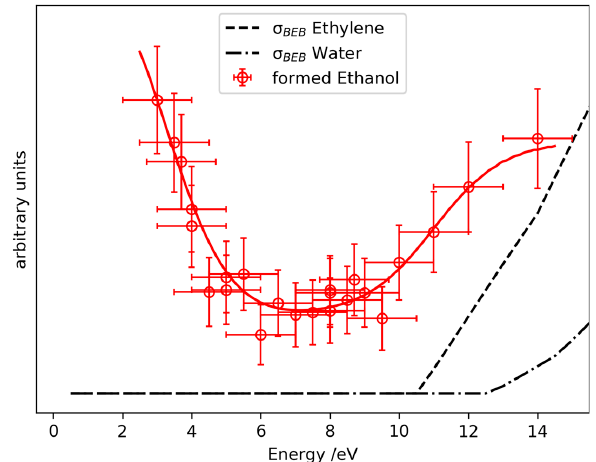
Figure 4. Predicted (black lines) electron impact cross-sections for ethylene and water. The amount of ethanol actually formed by electron irradiation of a 1:1 mixture of ethylene and water is shown in red circles. The red line only serves as a guide to the eye. Experimental data taken from Warneke et al. [22].